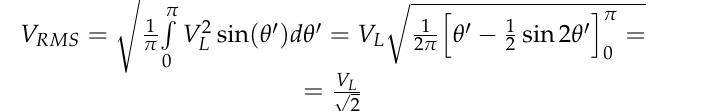
where θ ’ is replacing ( ω L t ). The apparent power coming out of the input rectifier is